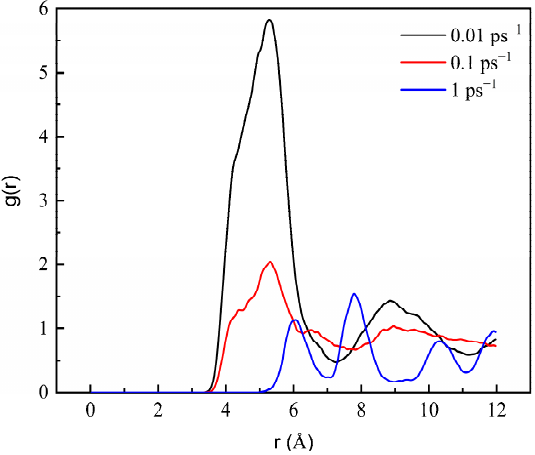
Figure 9. RDF of wax molecules at 293.15 K at different shear rates.